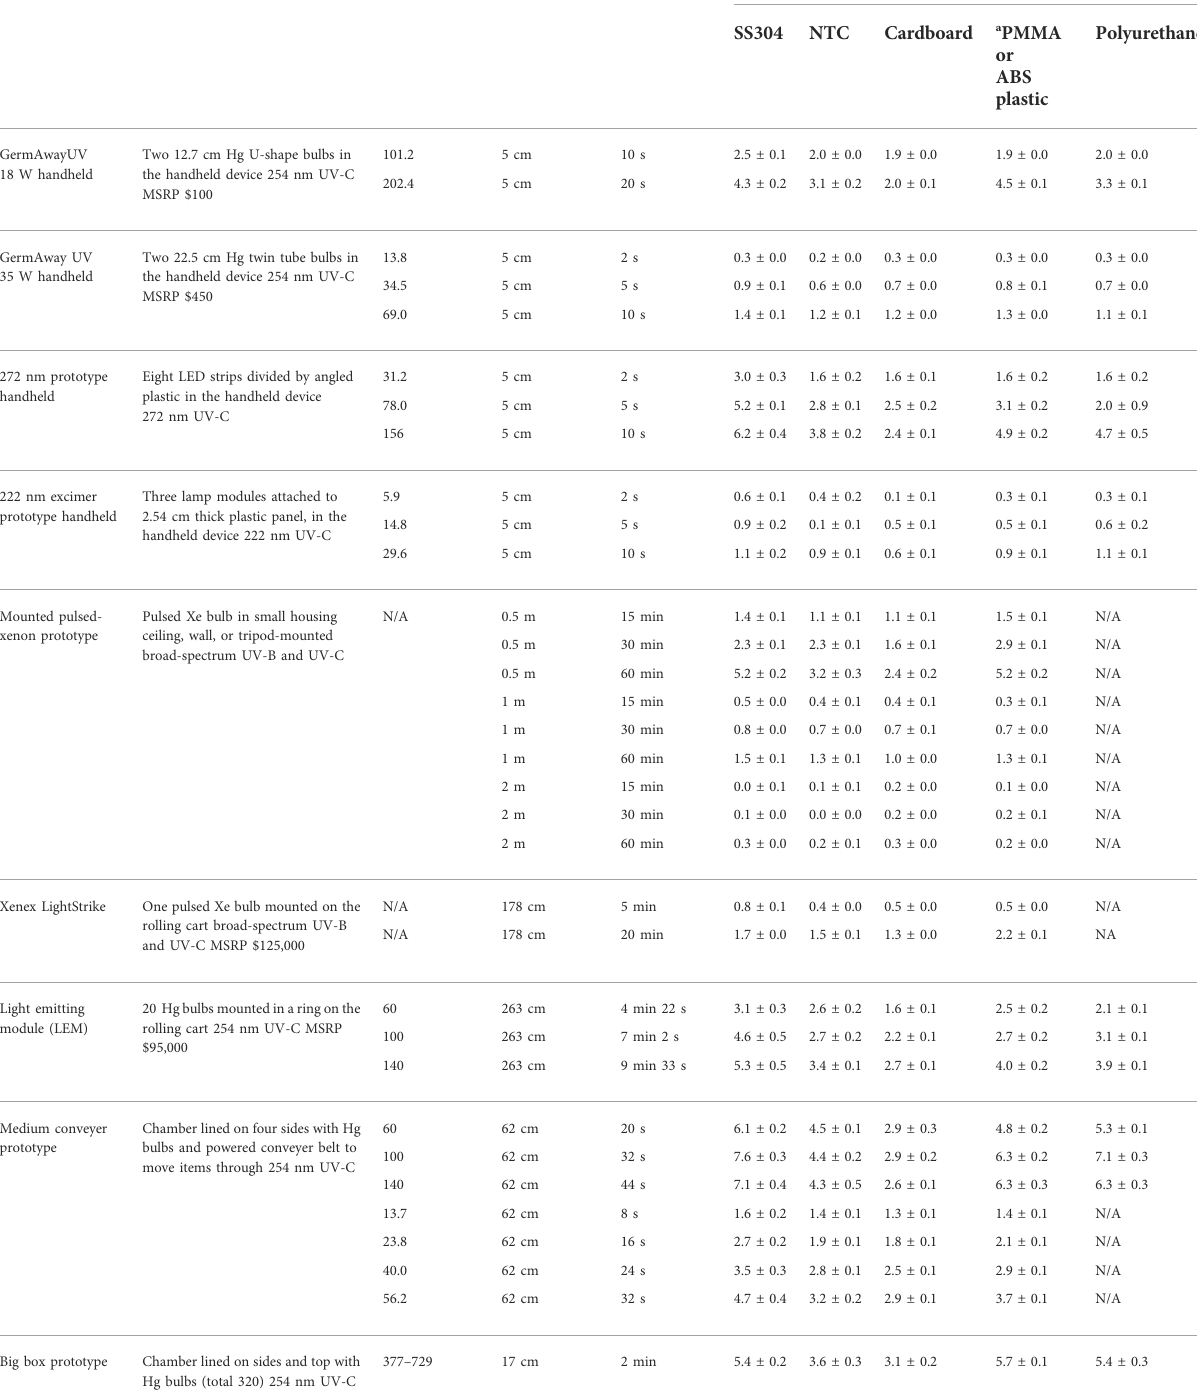
TABLE 2 Dosage and ef fi cacy of handheld, room, and chamber-type devices showing log 10 reduction data based on the steady-state emission, not peak emission. White (low decontamination) = Fail < 2 log 10 ; yellow (sanitation) = Fail ≥ 2 log 10 , < 3 log 10 ; light blue (disinfection) = Pass ≥ 3 log 10 ; and dark blue (approaching virus sterilization) = Pass ≥ 6 log 10 . N/A — dosage measurements had no meaning because of the broad-spectrum Xe source. Name Description Dosage Exposure Exposure (mJ cm − 2 ) distance time